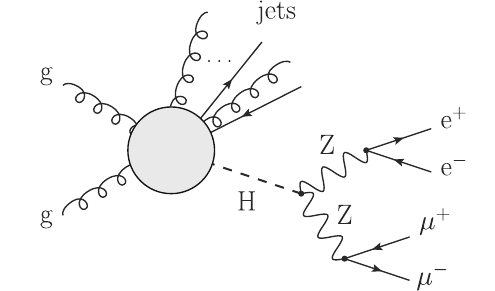
Fig. 1 General structure of the Standard Model amplitude for the pro- duction of a Higgs boson (decaying into four charged leptons) in asso- ciation with